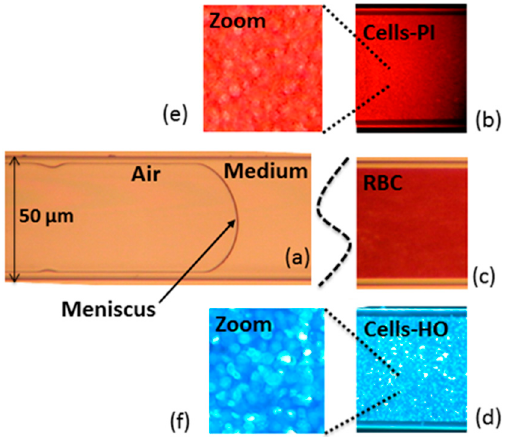
Figure 2. Microscopy images taken on capillaries after sample preparation. On the left, ( a ) typical image in bright field of the reference regions filled with air and medium separated by a meniscus. On the right, typical results obtained on regions with cells: ( b ) fluorescence microscopy image of fixed cells labeled with PI; ( c ) bright field microscopy image of RBCs; ( d ) fluorescence microscopy image of un-fixed cells labeled with HO; ( e ) zoom of ( b ) and ( f ) zoom of ( d ) for a better visualization of cells.